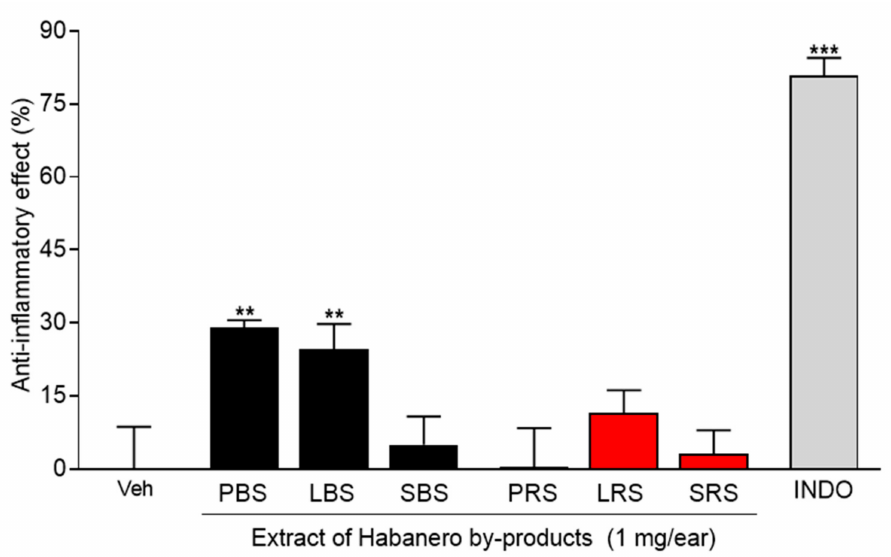
Figure 1. Anti-inflammatory effect of the methanolic extracts obtained by maceration from peduncles (P), leaves (L), and stems (S) of plants of C. chinense grown in black (BS) or red soils (RS) of Yucat á n in the mouse model of TPA-induced ear edema. Each bar represents the mean ± SEM (n = 6–8 per group). ** p < 0.01, *** p < 0.001, different from the vehicle (Veh) group by one-way ANOVA followed by Dunnett’s test. INDO: